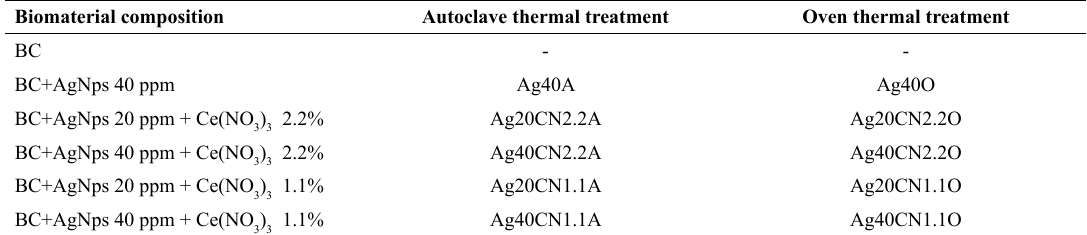
Table 1. Concentrations of Ce(NO symbology of the